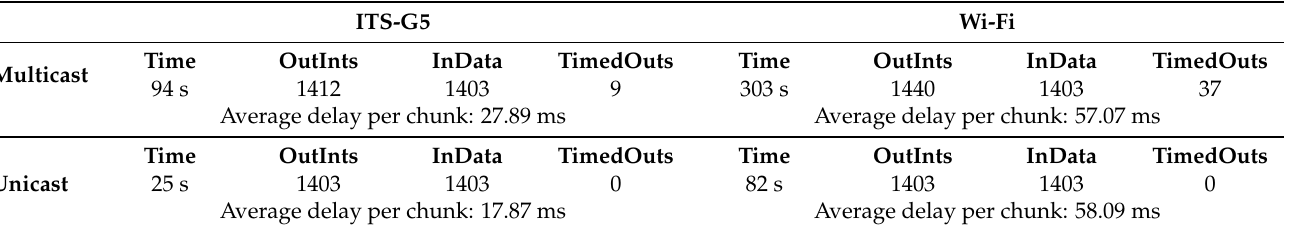
Table 2. Non-pipelined results—full 6 MB file using ITS-G5 or